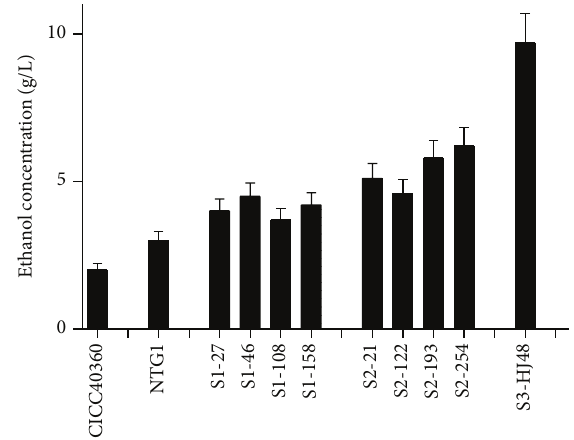
Figure 1: Improvement of ethanol yield by genome shuffling. One to threeroundsofgenomeshufflingwereusedtoimproveethanolyield of Trichoderma reesei CICC 40360. S1: the first round of genome shuffling; S2: the second round of genome shuffling; S3: the third round of genome shuffling. The bars represent mean ethanol yield with less than 10% standard